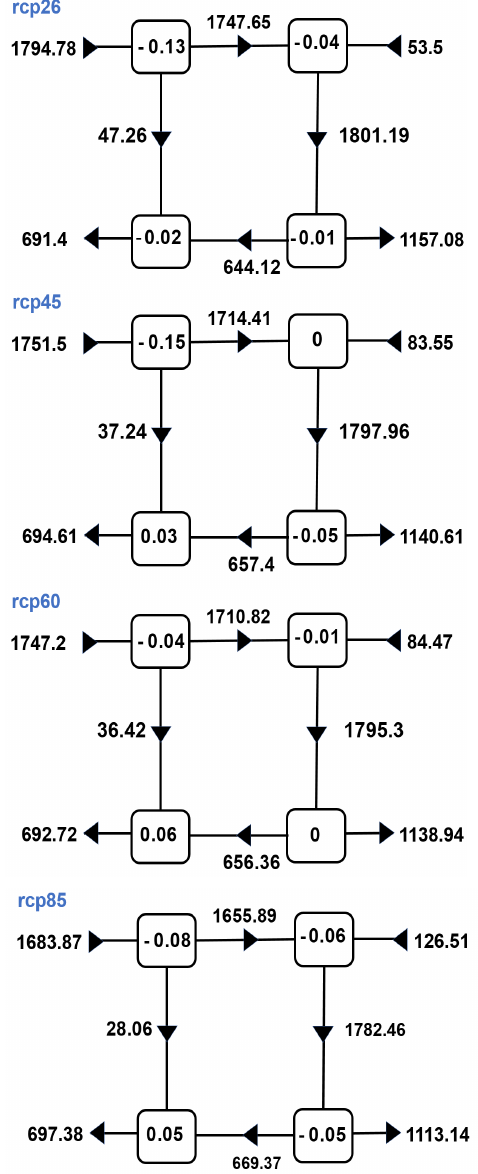
Figure 2. Mean Lorenz energy cycle for the four RCPs shown on the top left of each diagram. Units are in 10 − 3 Wm − 2 .